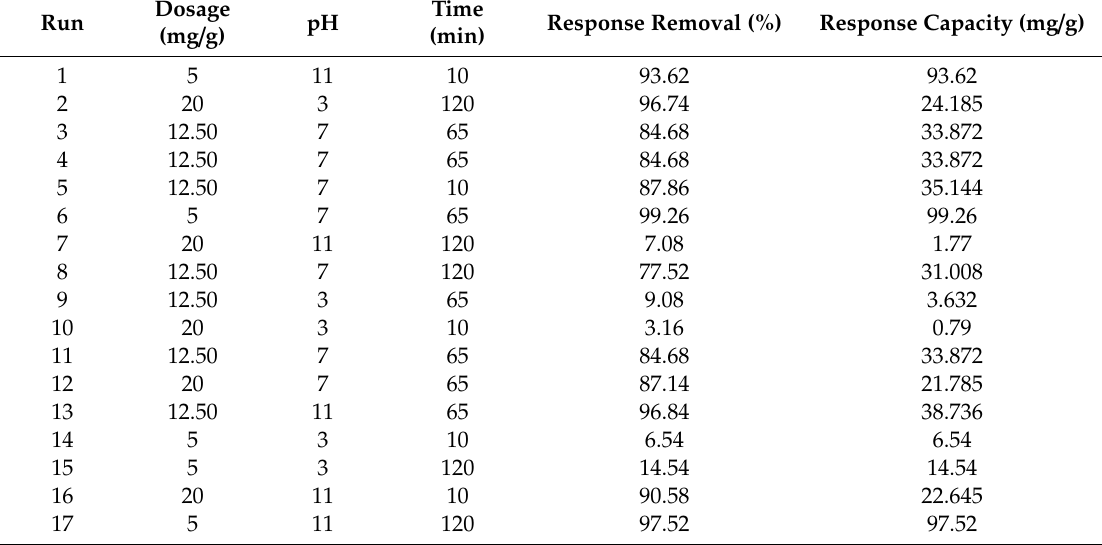
Table 1. List of design of experiments runs and the actual values obtained from each response. Dosage Time Run pH Response Removal (mg / g) (min)